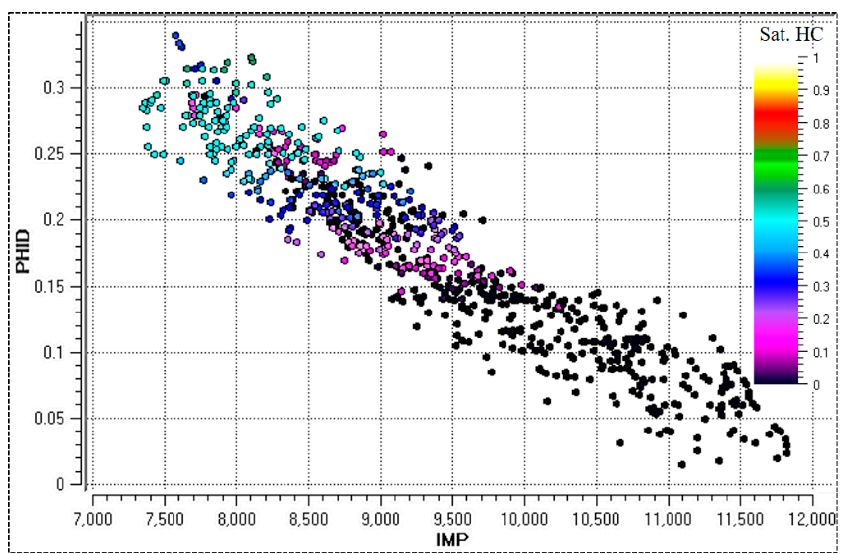
Figure 14. A cross-plot of acoustic impedance (AI) and porosity with a color bar representing hydrocarbon saturation values (Sat. HC).